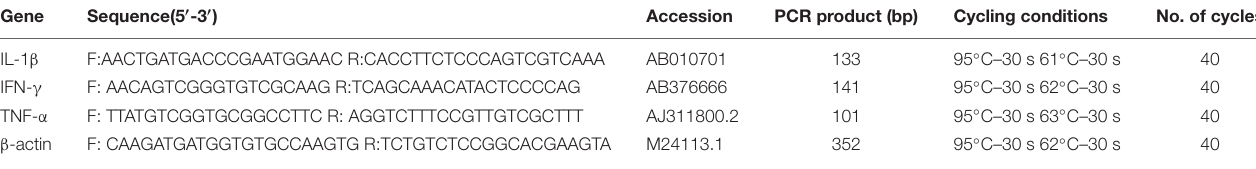
TABLE 2 | Sequences and conditions of the primers used in RT-PCR